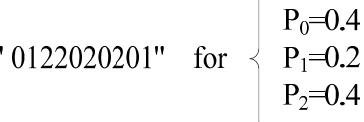
= 1 . In Figure 1, a probability vector of a ternary-